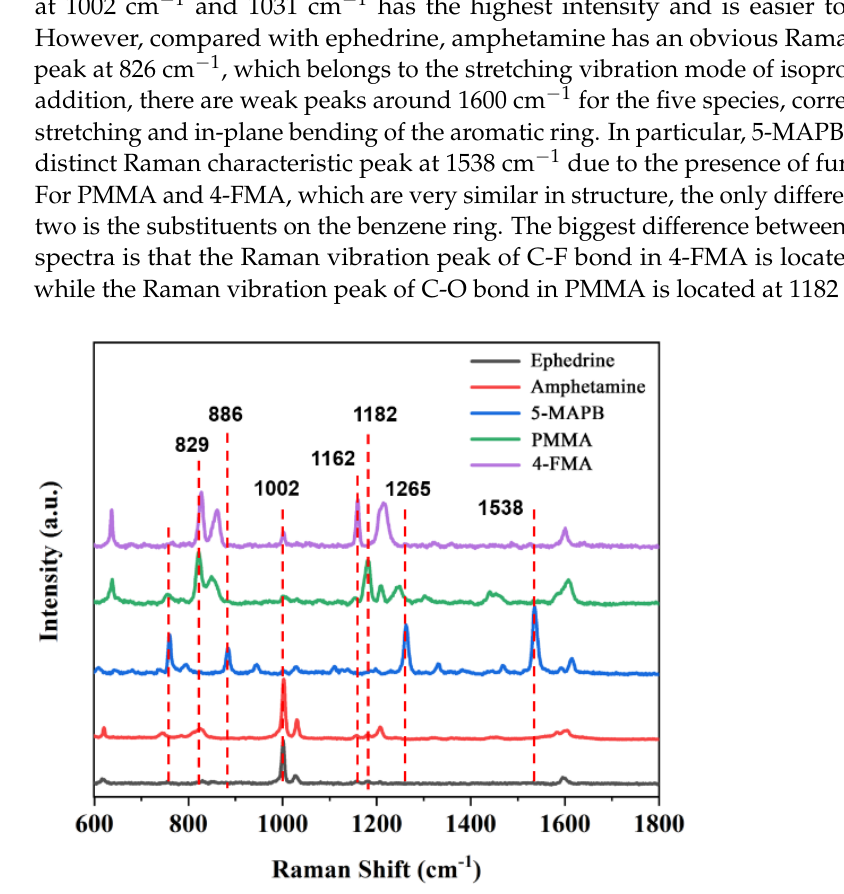
Figure 7. SERS spectra of Ephedrine, Amphetamine, 5-MAPB, PMMA and 4-FMA. The concentration is 2 g/L.